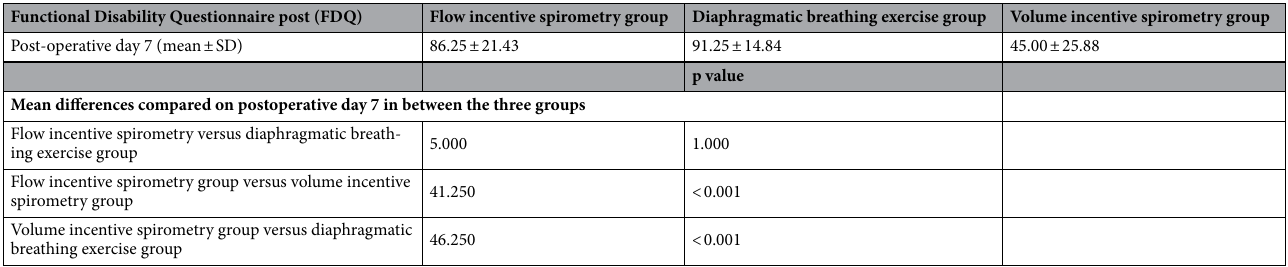
Table 4. Comparison of functional disability questionnaire post cardiac surgery (FDQ), on the post-operative day 7 between three intervention groups. p < 0.001 highly significant.